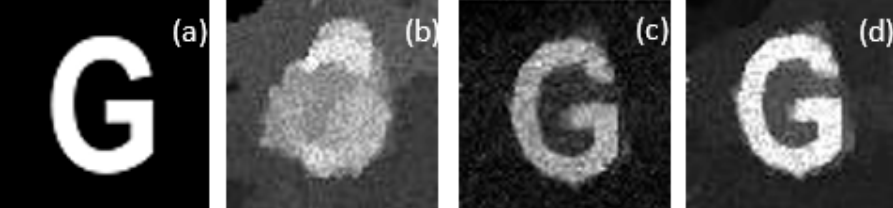
Figure 4. The images of different compression ratios that were reconstructed: ( a ) an original target image with pixels size 32 × 32 and ( b – d ) reconstructed images using different numbers of random speckle patterns (the M takes the values 50, 200, and 300, respectively, and different compression ratios from 4.88% and 19.53% to 29.29%).